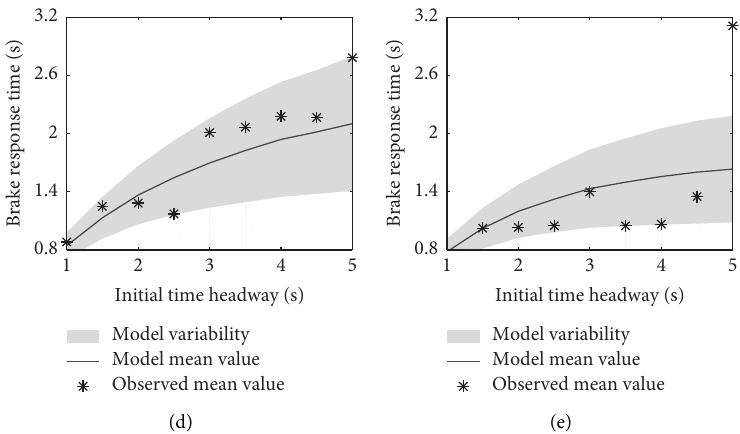
Figure 5: Simulation results versus observations obtained from simulator experiments, using _ θ . (a) No phone. (b) Hands-free (simple). (c) Handheld (simple). (d) Hands-free (complex). (e) Handheld (complex).